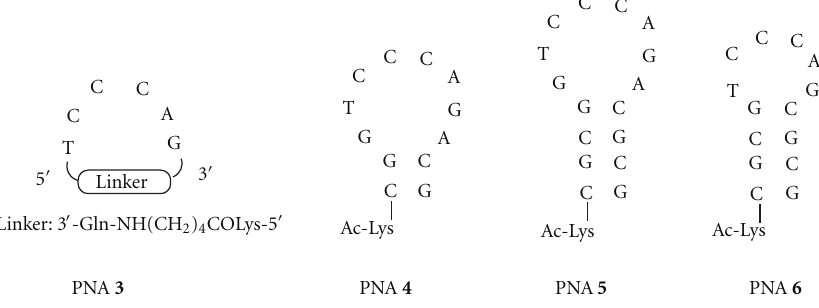
Figure 3: General structures of cyclic and hairpin PNAs synthesized in the present study.